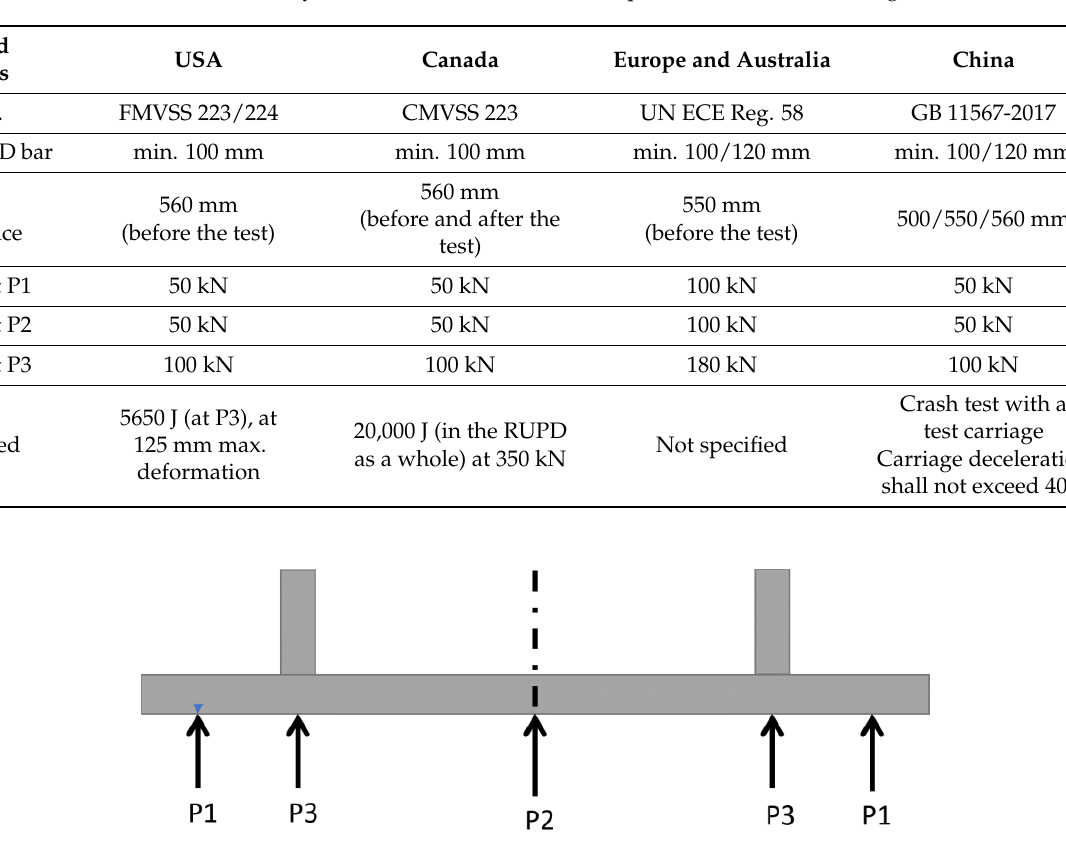
Table 3. Summary of the RUPD test conditions required in selected world regions.